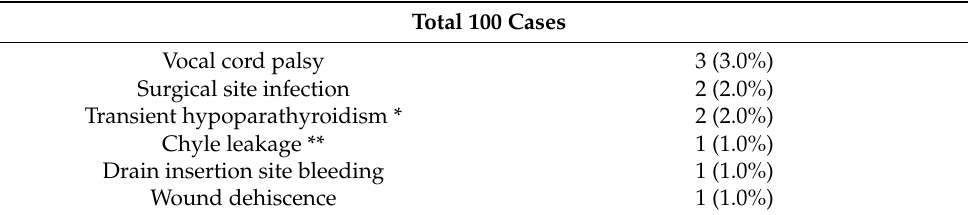
Table 4. Postoperative complications of the study